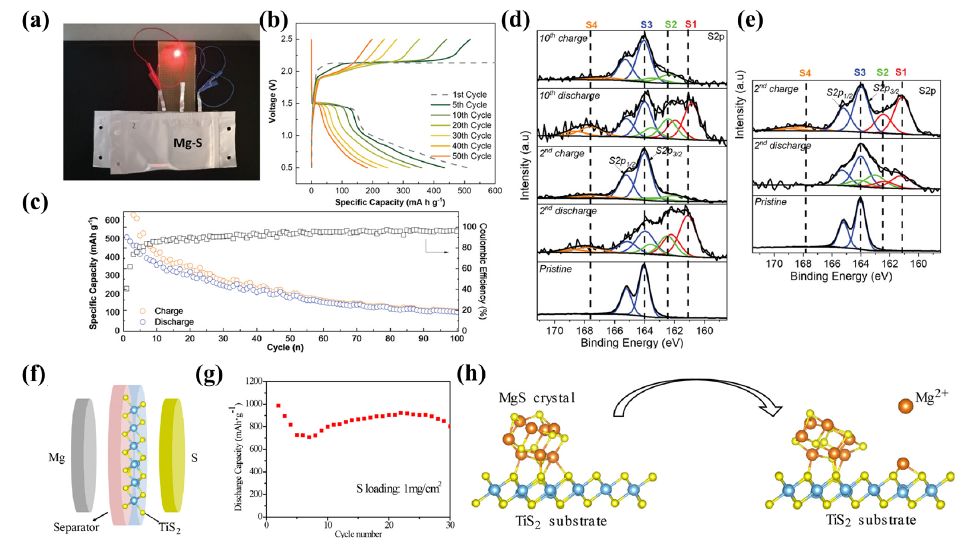
Figure 12. ( a ) Light up LED test by connecting two Mg − S pouch cells with CG@CP. Electrochemical performance of Mg − S pouch cell with CG@CP: ( b ) discharge −charge profiles, ( c ) Long term cycling at 0.05 C. ( d ) S 2p XPS of the S/KB cathodes ( d ) with CG@CP and ( e ) without CG@CP at various cycling state [44] . Mg −S battery with TiS 2 @separator: ( f ) Structure diagram. ( g ) Cycling stability. ( h ) TiS 2 catalysis in Mg − S cells [19].